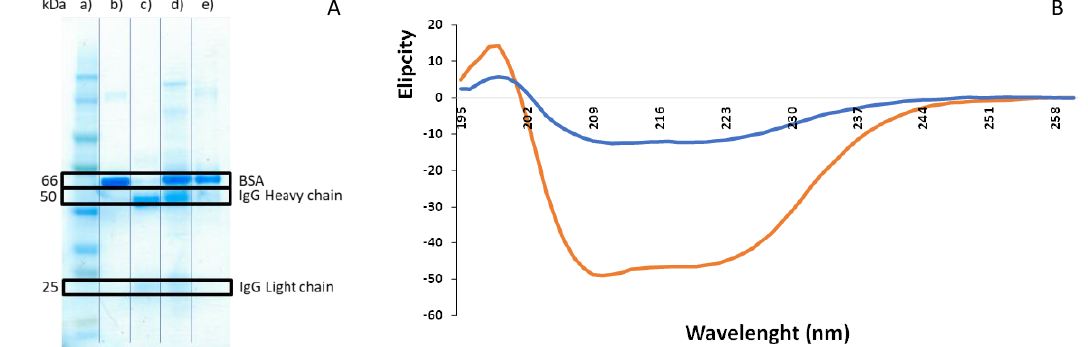
Figure 5. ( A ) — SDS-Page gel analysis of (a) Molecular weight marker, (b) Bovine serum albumin, (c) Immunoglobulin G, (d) Bovine Serum diluted at 1:100 ( v:v ), (e) Ionic-liquid-rich phase of the [N 4444 ][Ac] system after an ultrafiltration step, with Bovine serum albumin and Immunoglobulin G chains identified; ( B ) — Circular dichroism analysis to evaluate the Bovine serum albumin secondary structure stability in the ionic-liquid-rich phase ( –– ) and pure Bovine serum albumin at 0.25 mg.mL −1 ( –– ).